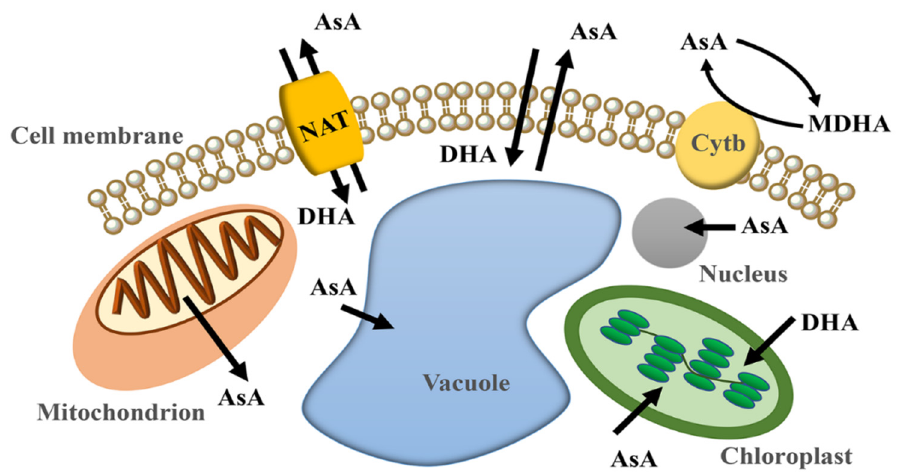
Figure 2. The AsA transport in plant cell. AsA is synthesized on the inner mitochondrial membrane and transported into the cytoplasm. AsA in the cytoplasm can enter organelles, such as vacuoles, chloroplasts, and nuclei, through diffusion or carriers. In addition, AsA can also be transported outside the cell membrane by simple diffusion or transport proteins. DHA in the apoplast can also enter the cell membrane and participate in the regeneration of AsA. Arrows indicate the direction of material transport. NAT, nucleobase/ascorbate transporter; Cytb, cytochrome